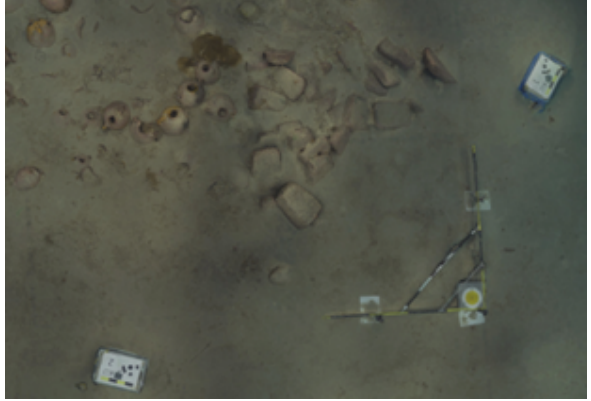
Figure 2. The tripod with spirit level and coded target. Photo: Dave Gration (2018).